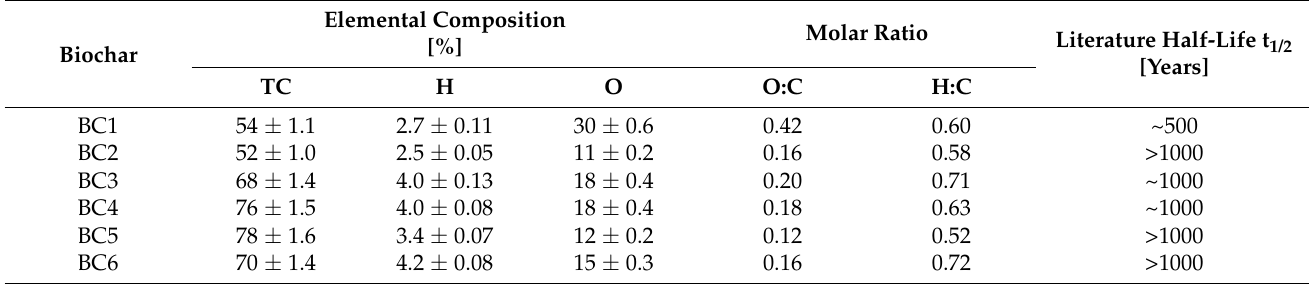
Table 2. Elemental composition, molar ratios, and estimated half-life time of biochars.